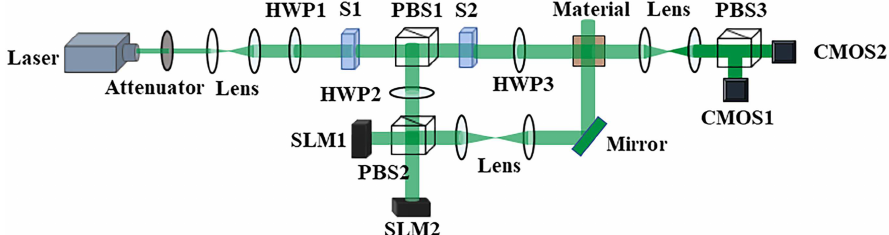
Figure 3. Polarization multichannel multiplexing device: S, HWP, PBS, SLM, and COMS are the shutter, half-wave plate, polarization beam splitter, spatial light modulation, and complementary metal oxide semiconductor sensor,